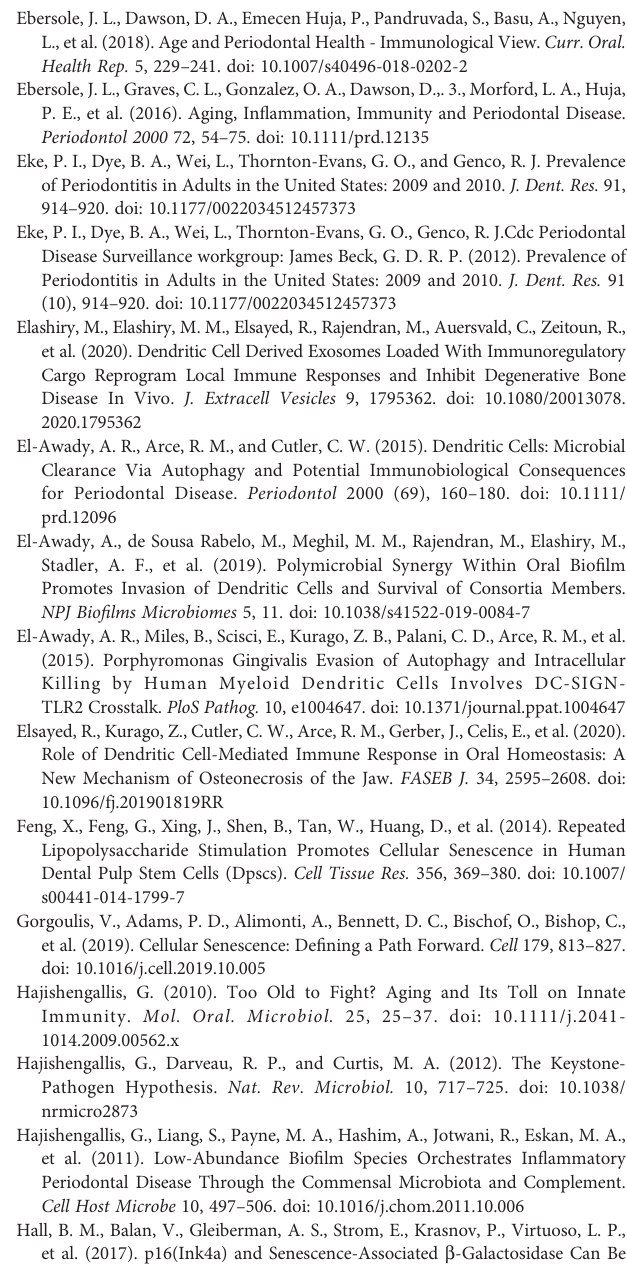
Supplementary Figure 1 | (A) Schematic diagram showing the work fl ow of magnetic separation of EXO labeled with CD81, CD9 and CD63. (B) Nano tracking analysis (NTA) to determine Exo number and size distribution in nanometer(nm) within the run through. Y-axis is linear in all three histograms, with the range being, fromleft toright: 10 11 ,10 8 , 10 7. (C) WB analysisof proteinsin the eluate andthe run through after magnetic